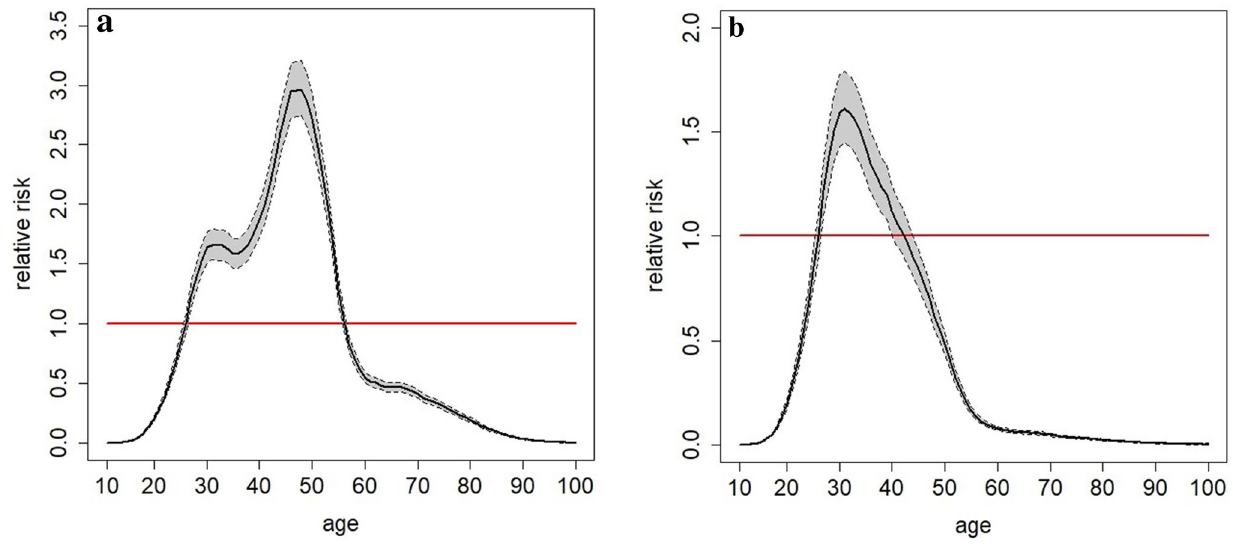
Figure 1. Relative risk of age, with 95% confidence interval compared to a reference case at 25 years (red line), ( a ) as regard all-type endometriosis cases, and ( b ) as regards non-adenomyosis cases.